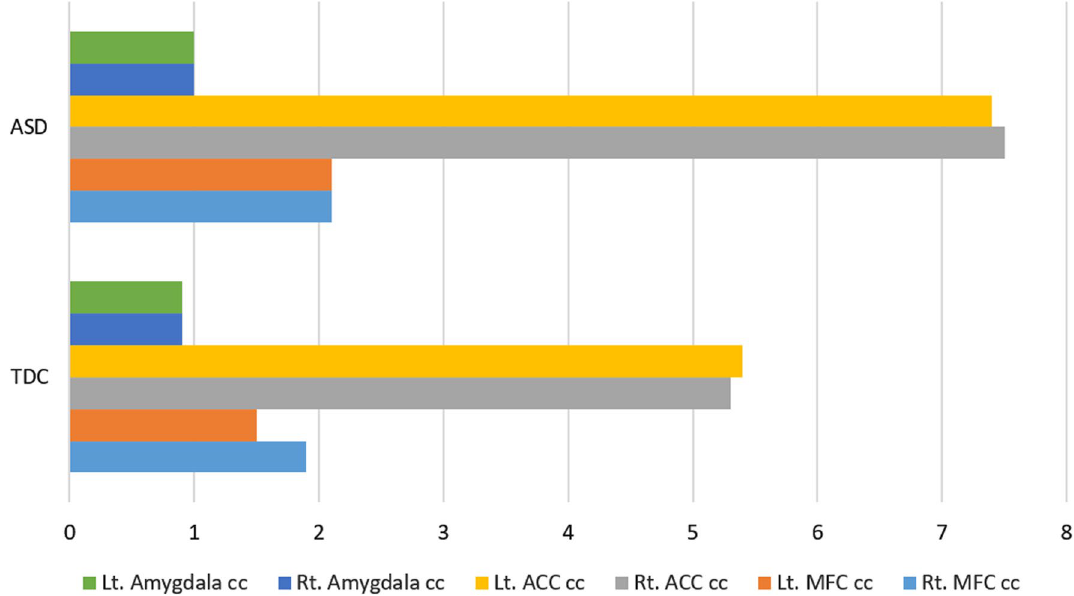
Fig. 4 Social brain components’ (other than anterior temporal lobe) mean volume in TDC and ASD groups. ACC Anterior cingulate cortex, MFC Medial frontal